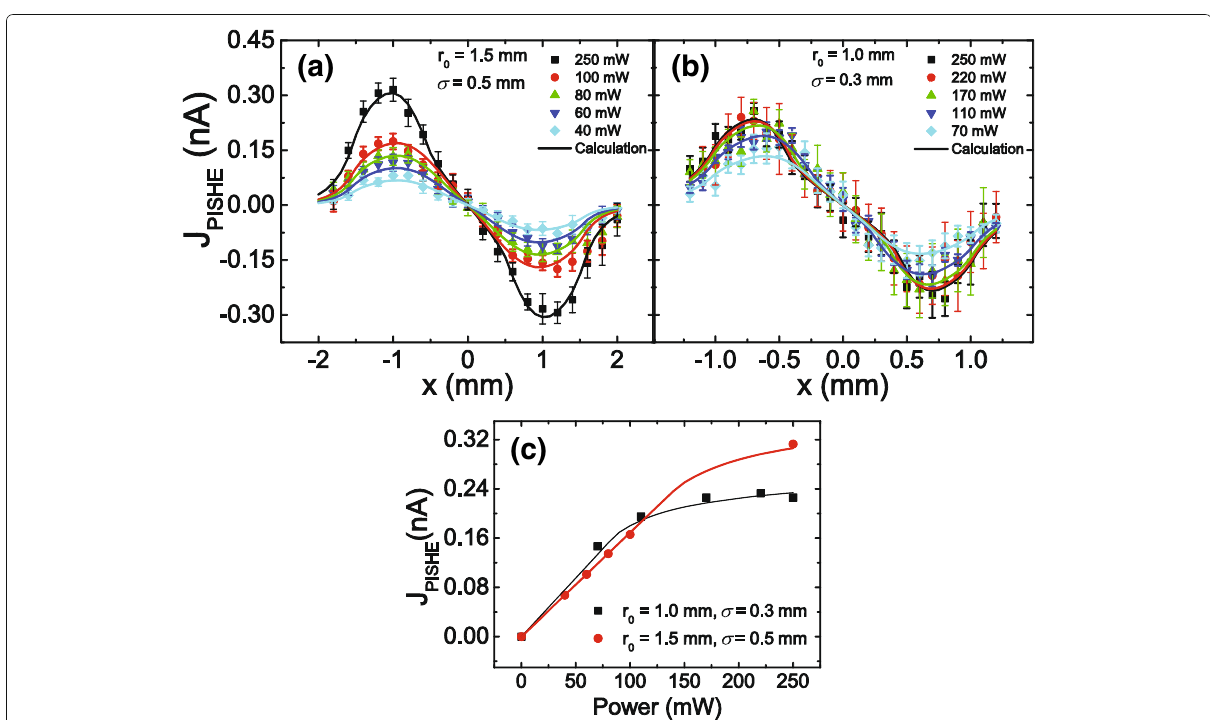
Fig. 2 PISHE current as a function of light spot locations under different light power. a , b PISHE current excited by a Gaussian profile light spot with